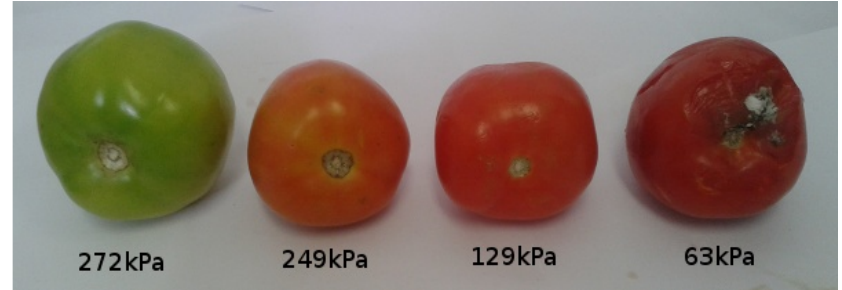
Figure 12. Turgor pressure in Kilo-Pascal (kPa) measured with the glove for tomato. The fruit on the left is more unripe and the one on the right is more ripe.